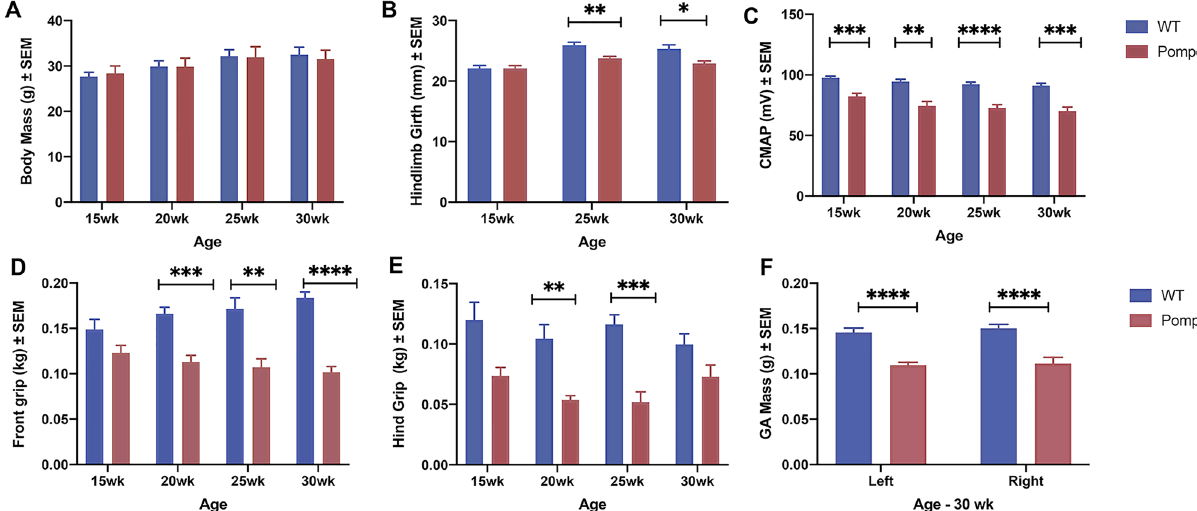
Figure 1. Physiological Data for WT and Pompe mice. Comparison of Body Mass ( A ), Hindlimb Girth ( B ), CMAP ( C ), Front Grip ( D ), and Hind Grip ( E ) between WT and Pompe mice at 15, 20, 25 and 30 weeks, and Gastrocnemius Wet Mass ( F ) at time of harvest (30 weeks). (N = 10 mice/group/time point). All data were reported as mean ± SEM. Statistical significance (Ordinary two–way ANOVA with Sidek’s Multiple comparisons test): * p < 0.05; ** p < 0.01; *** p < 0.001; **** p < 0.0001; ns not